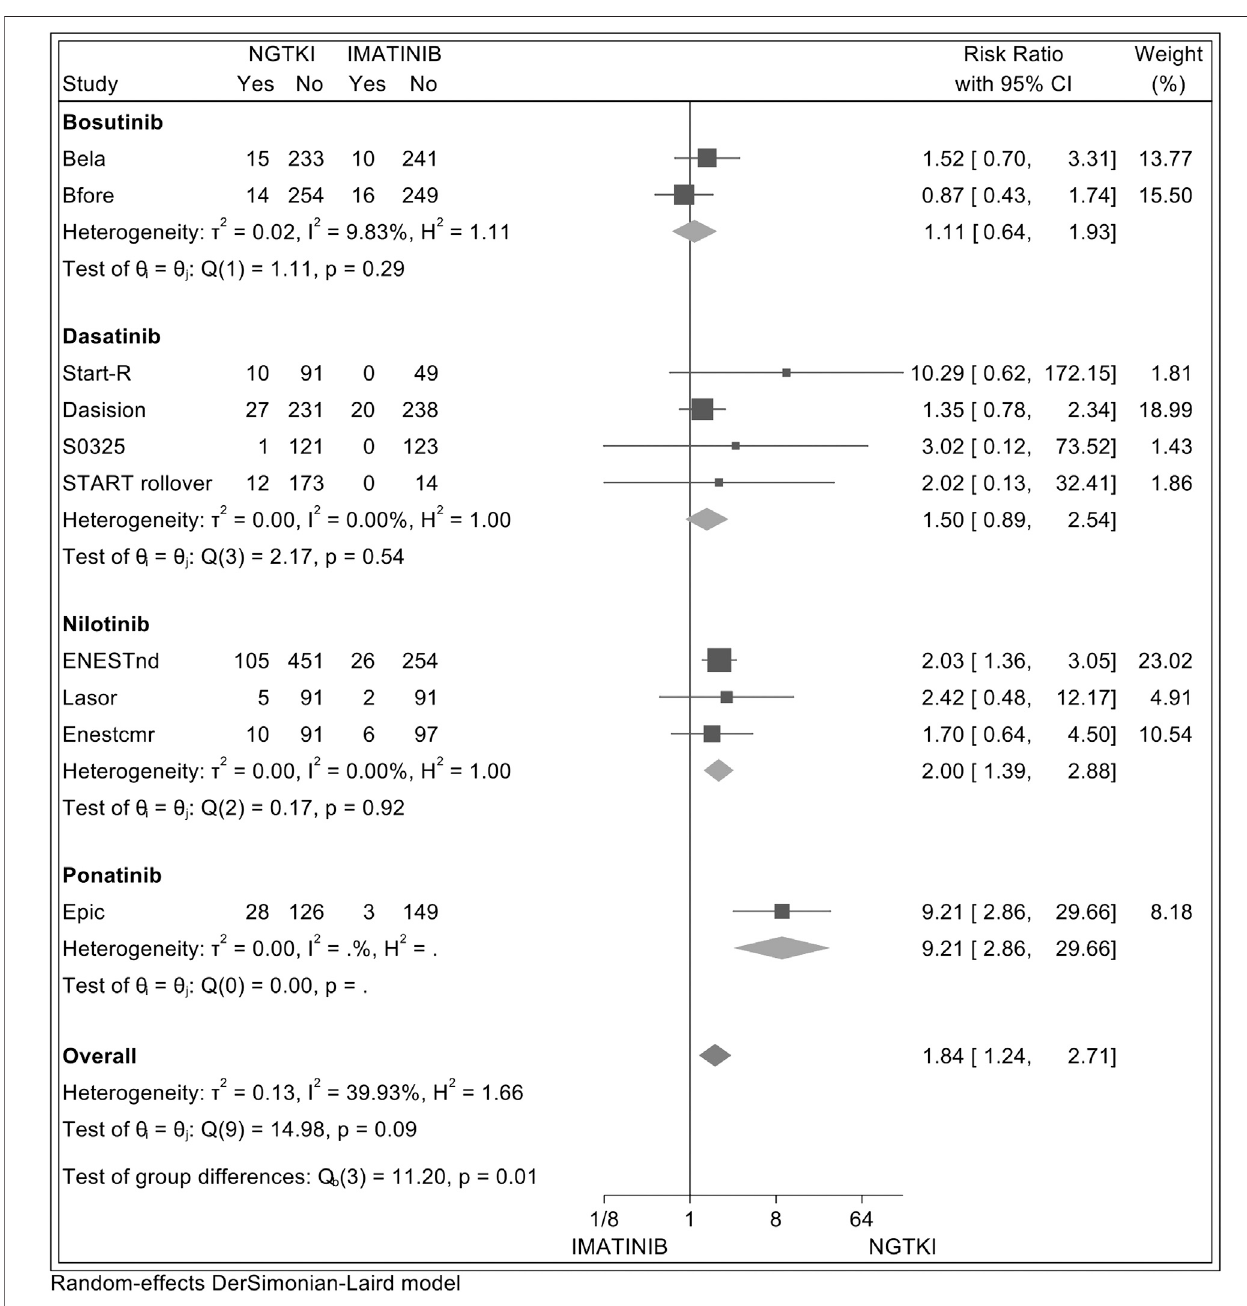
Frontiers in Pharmacology |